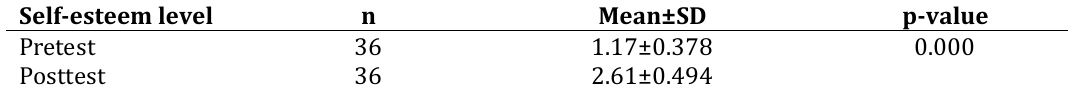
Table 6 The effect of life-review therapy on self-esteem among elderly with depression Self-esteem level n Mean±SD